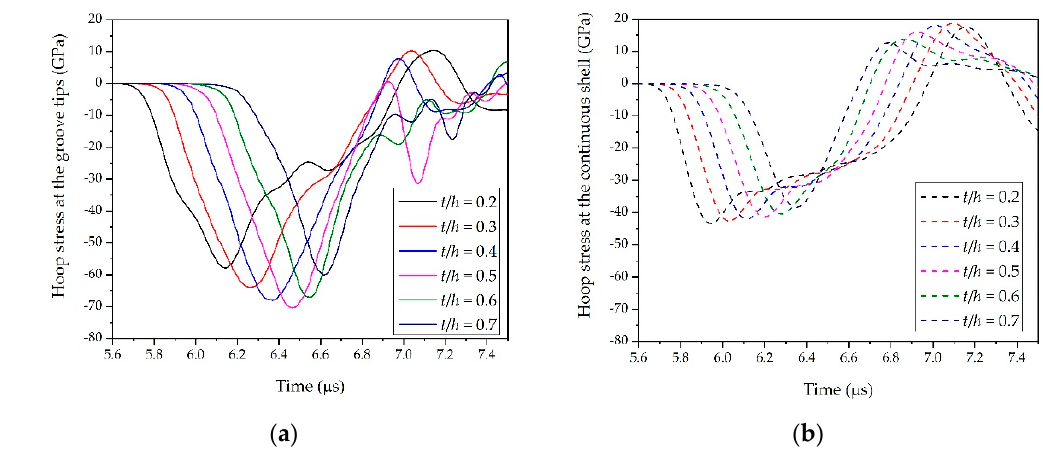
Figure 12. Hoop stress at groove tips and the stress at the same position inside continuous shell (NO. 4): ( a ) relationship between t / h and hoop stress at groove tips and ( b ) relationship between t / h and the stress at the same position inside the continuous shell.